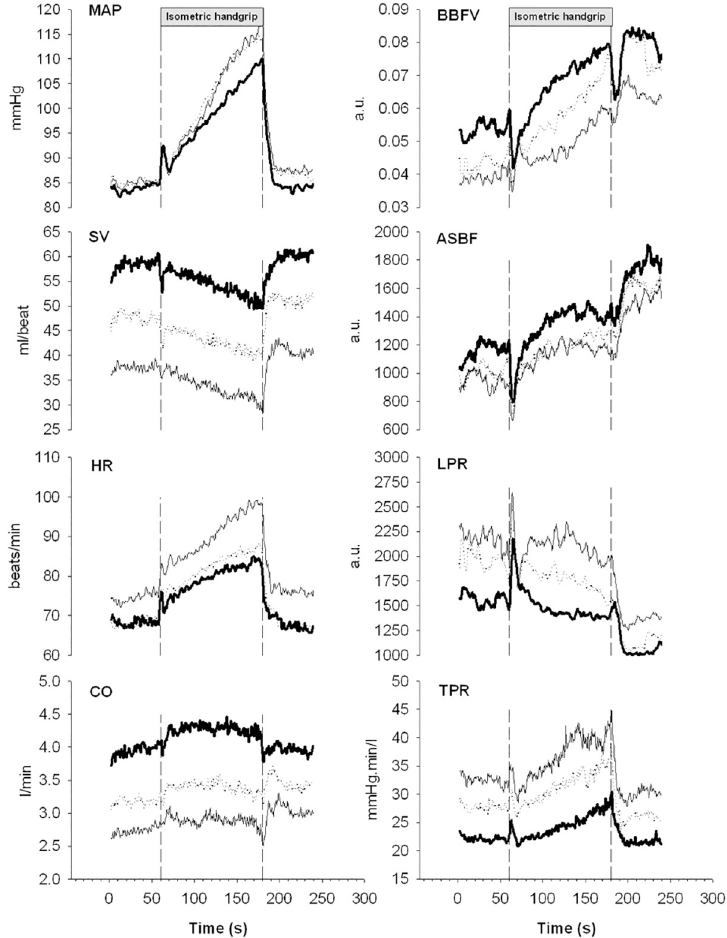
Fig 2. Pooled average trends of the individual cardiovascular responses (n = 11) to 2 minutes of isometric handgrip contraction (40% of maximal voluntary contraction force). Bold lines show mean arterial pressure (MAP), stroke volume (SV), heart rate (HR), cardiac output (CO), blood flow velocity in the brachial artery (BBFV), acral skin blood flow perfusion (ASBF), local peripheral resistance (LPR) and total peripheral resistance (TPR) during isometric handgrip in supine position (P1). Dotted lines show the responses during reduced preload induced by mild lower body negative pressure (LBNP -20 mmHg, P4)), and hairlines the responses during LBNP (-40 mmHg, P5).